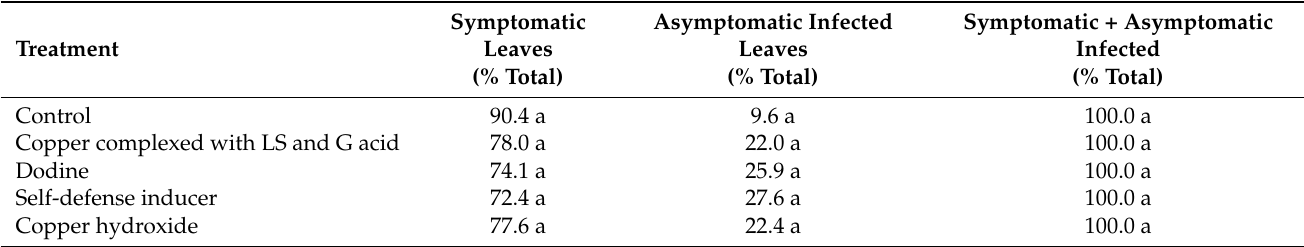
Table 2. Symptomatic and asymptomatic infected leaves at the beginning of the experiment (March 2021), on the trees where the different treatments were applied.